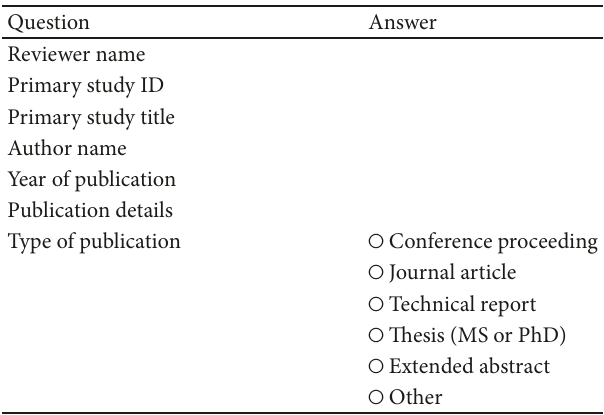
Table 13: General information